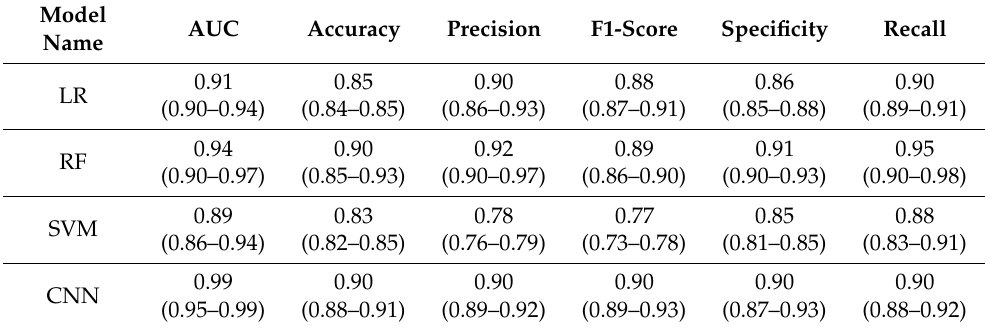
Table 3. Performance comparison of each model. (Estimates and 95% confidence